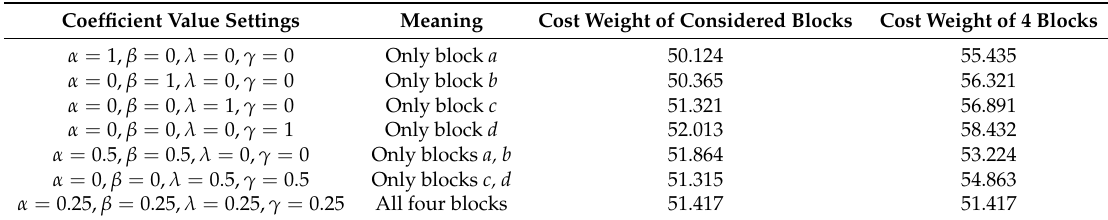
Table 2. Cost weight comparision between cost function of blocks for 10 × 10 workspace.